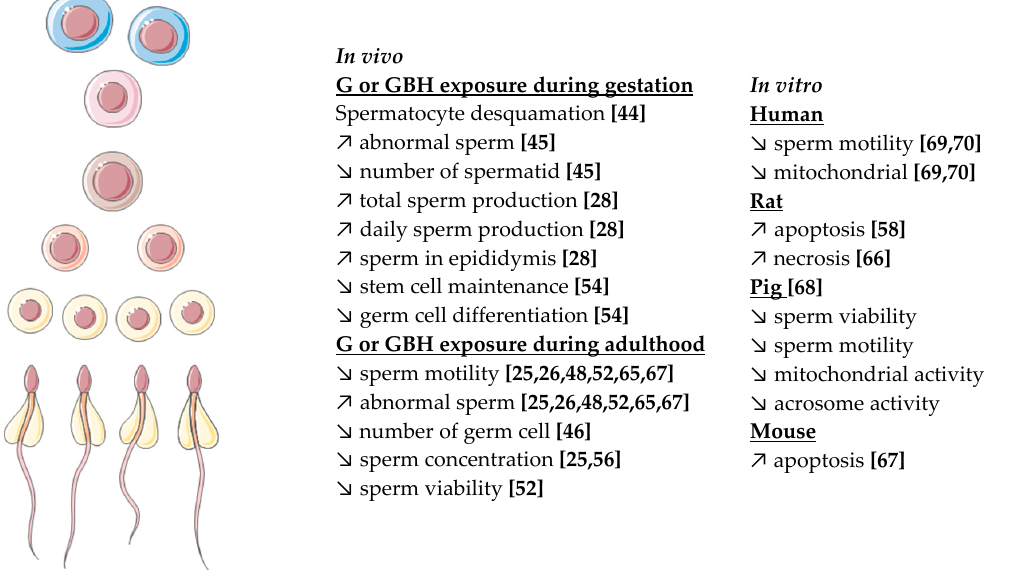
Figure 4. Summary of G or R in vivo and in vitro effects observed on spermatogenesis in different species. Numbering in brackets indicates references.